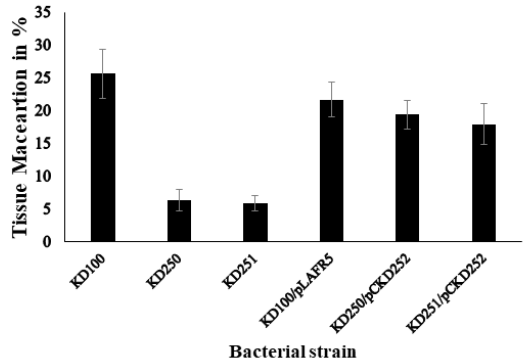
Figure 7. Tissues maceration capacity of each mutant was compared to the parental strain KD100. Bacteria cells were inoculated with 1.3 × 10 9 CFU/mL in carrot disks and weight of macerated tissue was determined after 48 h of incubation at 28 °C. Data represents mean percentage weights of macerated tissue (from four replicates) ± standard deviation.